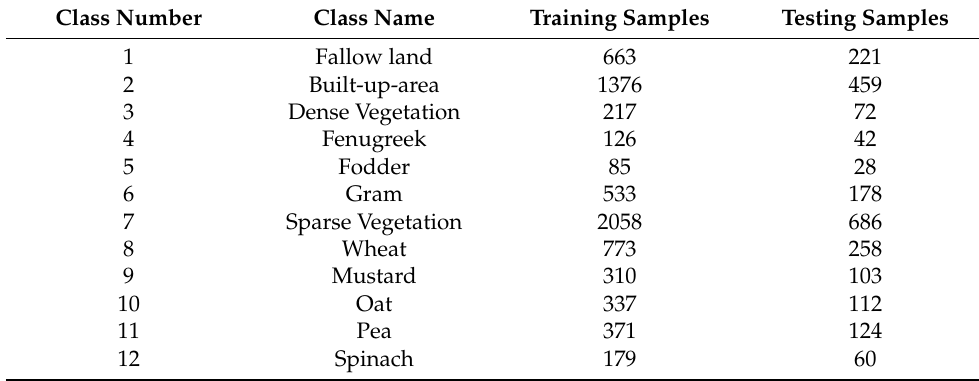
Table 1. Total samples used for training and testing in S2, fused S1 and S2 images.